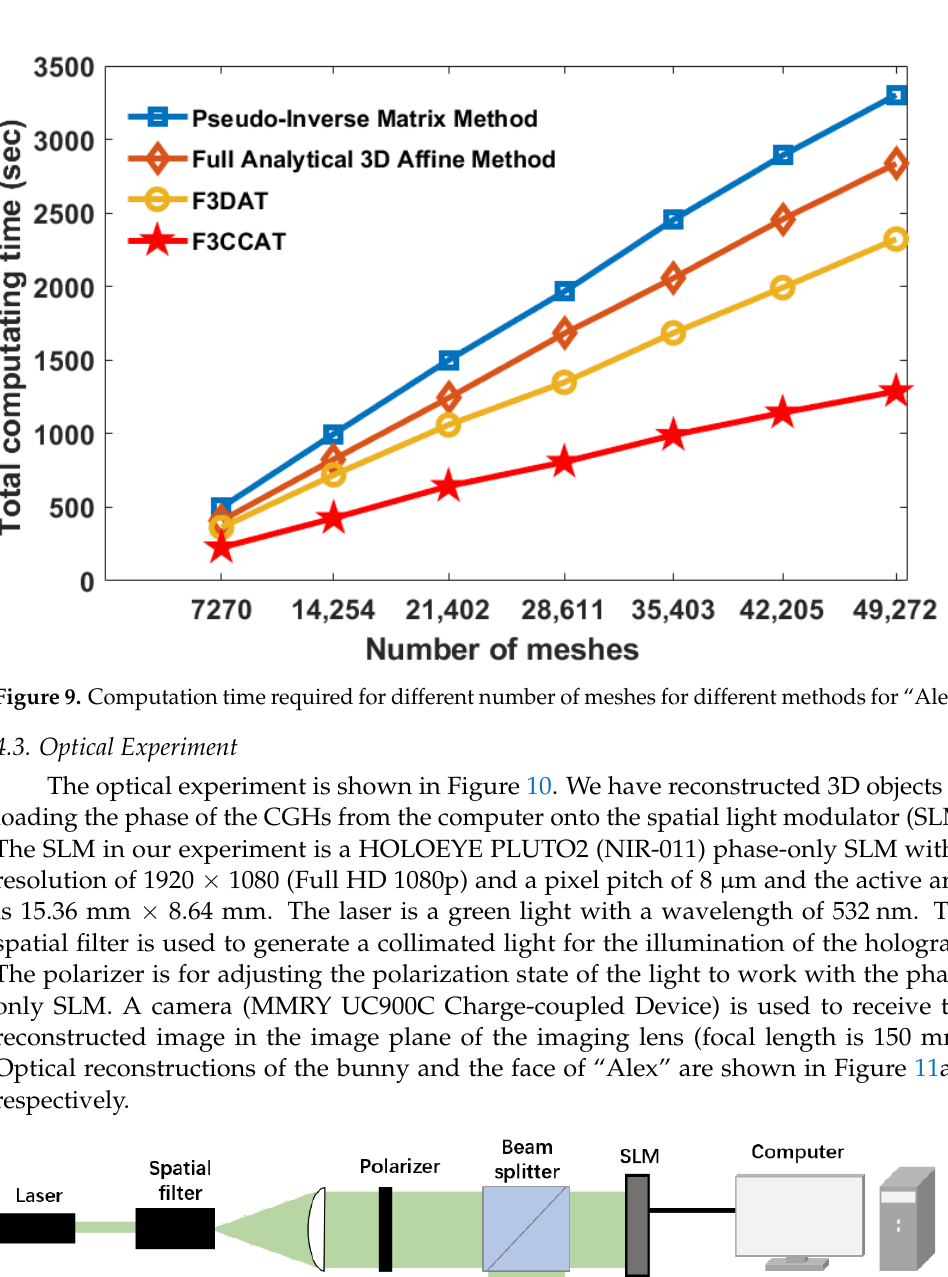
Figure 11. Results of optical reconstruction: ( a ) bunny and ( b ) Alex. 5. Conclusions In conclusion, we have proposed an improved algorithm to obtain a full-analytical spectrum of a tilted triangle based on 3D affine transformation. Our method avoids the time-consuming steps such as the need to solve for the pseudo inverse matrix or the com- plex process of 3D rotation and transformation. We have verified our method by calculat- ing complex 3D objects composed of tens of thousands of meshes. In addition, we have added flat shading for realistic image presentation. We have successfully obtained the reconstructed images by numerical and optical reconstructions. Through comparison, it is found that our method improves the computational efficiency by about two times com- pared with the previous affine methods. Author Contributions: Conceptualization, B.Z. and Y.Z.; formal analysis, Y.Z.; methodology, soft- ware, H.F., F.W.; investigation and validation, H.F., W.Q. and Q.F.; writing—original draft, H.F.; writing—review and editing, Y.Z. and T.-C.P. All authors have read and agreed to the published version of the manuscript. Funding: This research was funded by National Natural Science Foundation of China (61865007) and Yunnan Provincial Science and Technology Department (2019FA025). Data Availability Statement: Original data are available in Ref. [43].